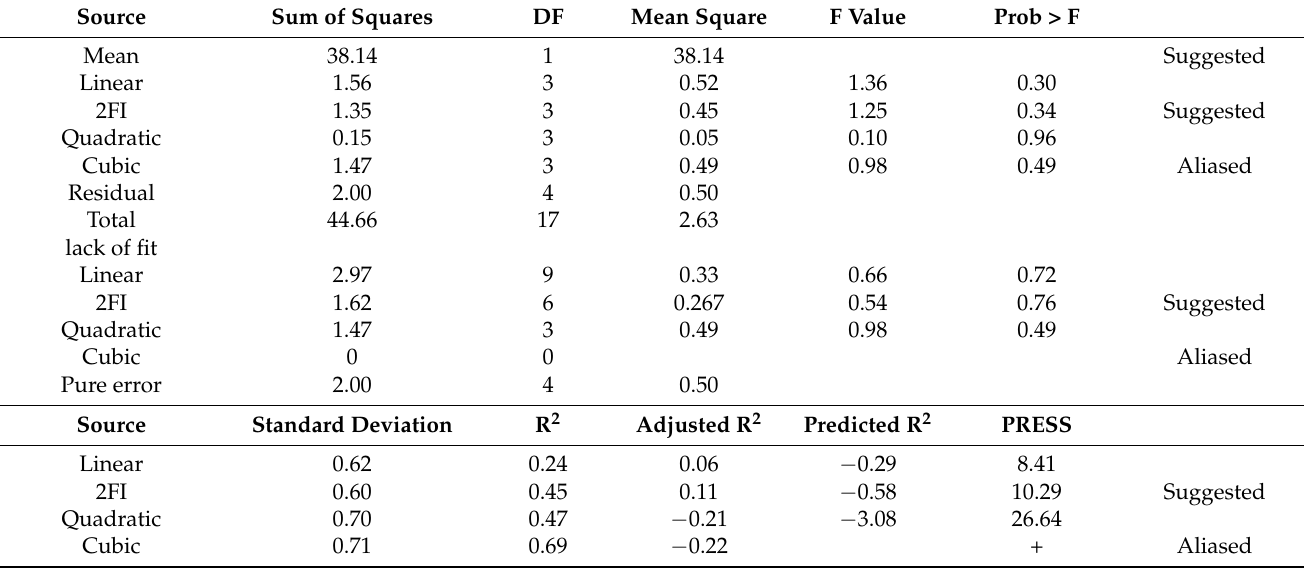
Figure 4. Design matrix evaluation for response surface of 2FI model. Table 4. Adequacy of model for adsorption capacity